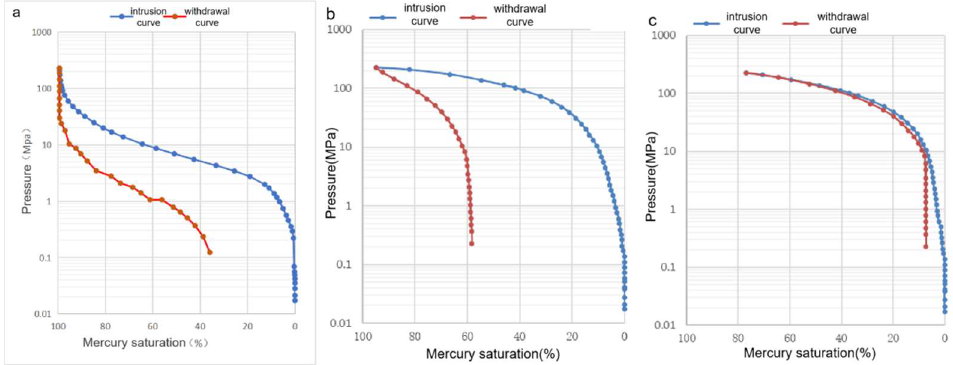
Figure 8. Mercury intrusion experiment curves. ( a ) GY600 of semicolsed system ( b ) Longmaxi formation type II and ( c ) Longmaxi Formation type I.